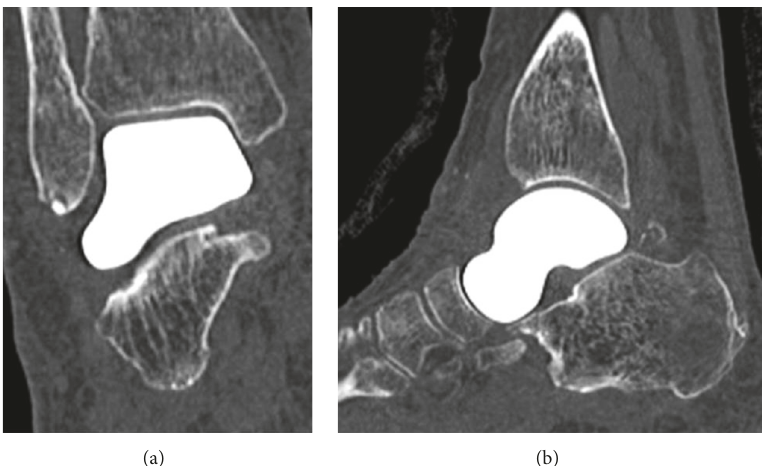
Figure 5: Postoperative CT scans showing good alignment of the prosthesis and surrounding bones in coronal (a) and sagittal (b) views at 1 year and 6 months after surgery. There is no osteolytic change in the surrounding bones or sinking of the prosthesis.